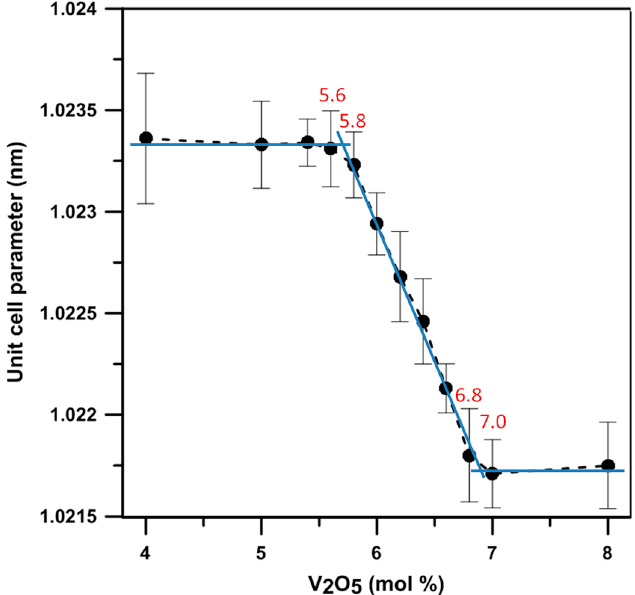
Figure 6. Lattice constants of γ phase (Bi 1 − x ,V x ) 2 O 3 with the V 2 O 5 doping levels from 4 to 8 mol%.